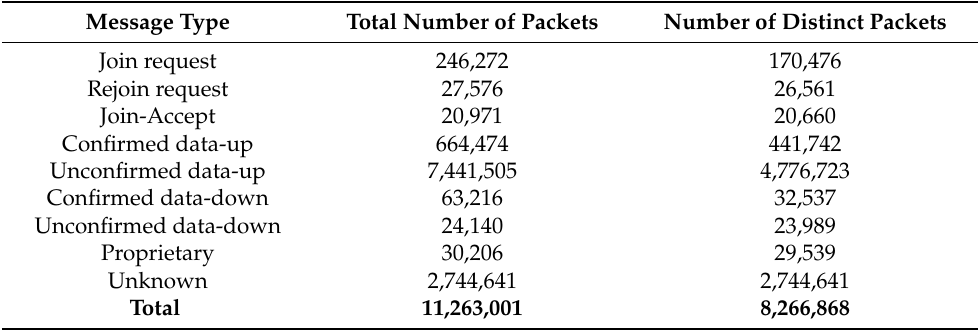
Table 3. Number of packets contained in LoED dataset grouped by message type. In the centre column it is reported the total number of packets including the duplicates, while on the right it is reported the number without